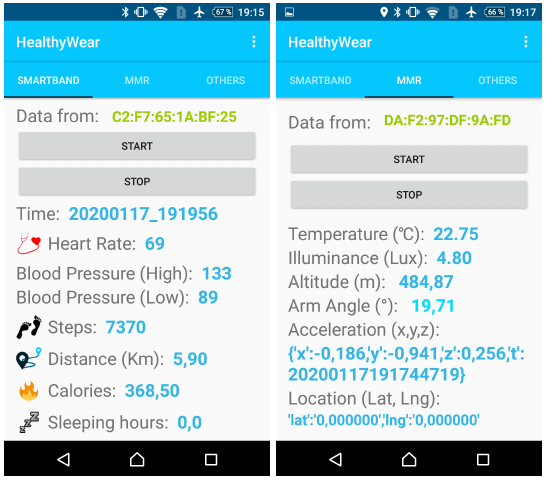
Figure 8. Informative phone